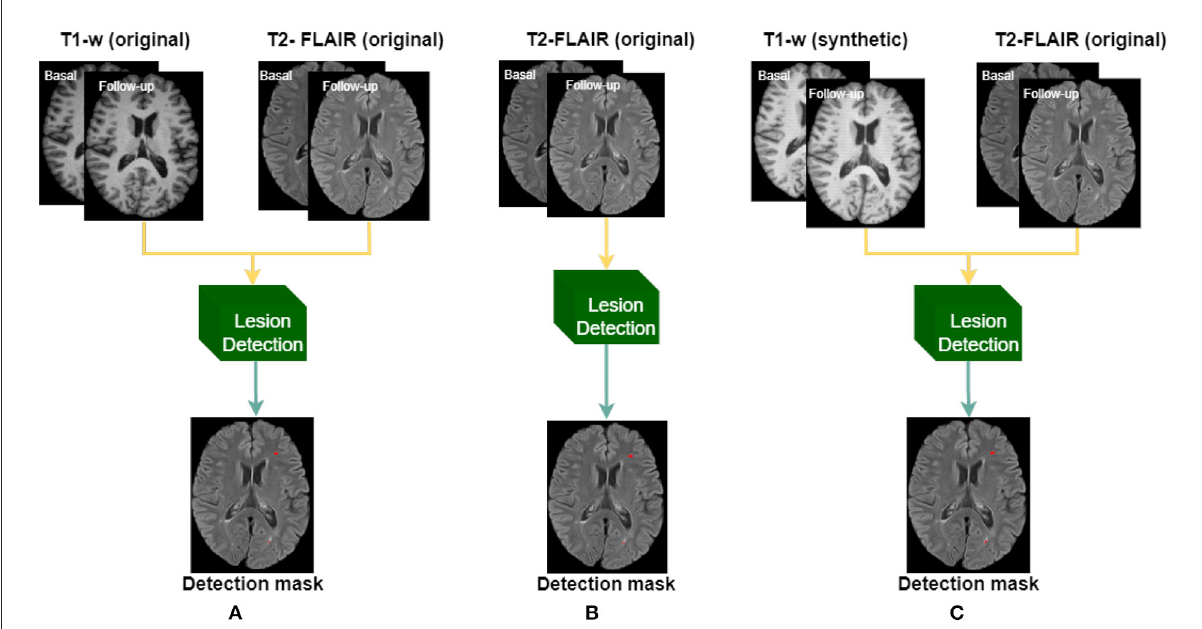
FIGURE3 Three different models are trained according to the input images: (A) original T1-w and T2-FLAIR images, (B) using only original T2-FLAIR images, and (C) using synthetically obtained T1-w images (from the original T2-FLAIR images) along with the original T2-FLAIR